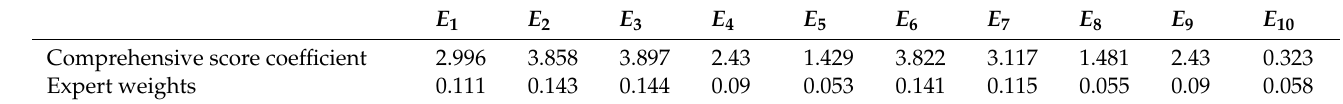
Table 10. Experts’ qualification level weights.